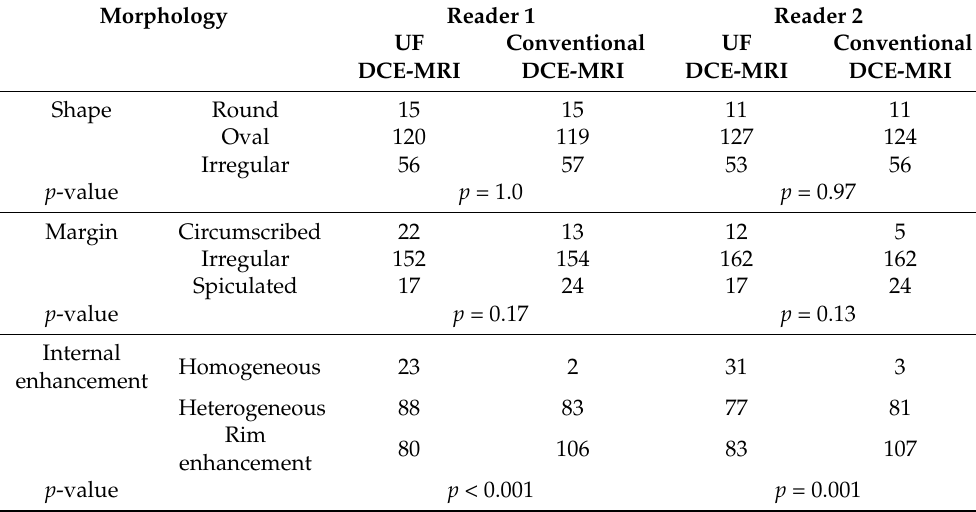
Table 4. Number of lesions showing specific morphological descriptors on the UF DCE-MRI and conventional DCE-MRI evaluations. Morphology Reader 1